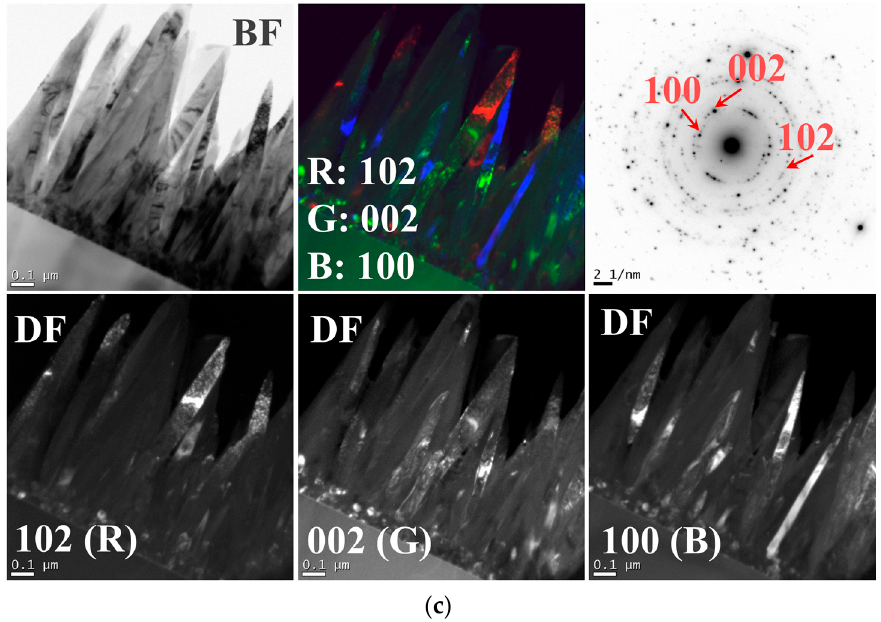
Figure 4. Cross-sectional TEM micrographs of the ZnO NRs grown on SLs annealed in ( a ) vacuum, ( b ) air, and ( c ) nitrogen ambients. Bright-field images and their selected area electron diffraction (SAED) patterns are respectively shown in (top-left) and (top-right). Dark field images are shown according to each different diffraction condition of plane index in (bottom rows) with (top-center) their composite views in three different colors.